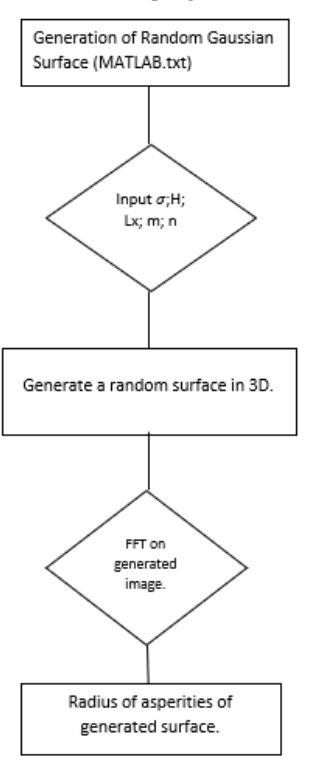
Figure 4. Flow Chart of MATLAB Program